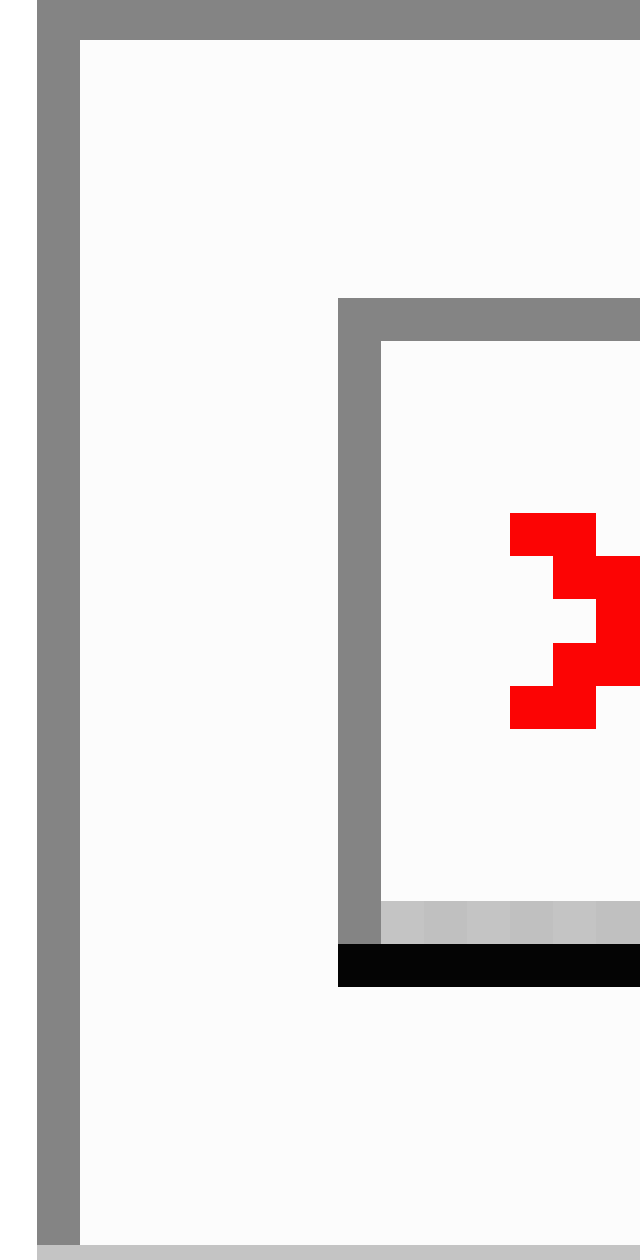
Figure 1. Quiz acceptance rates across quizzes by